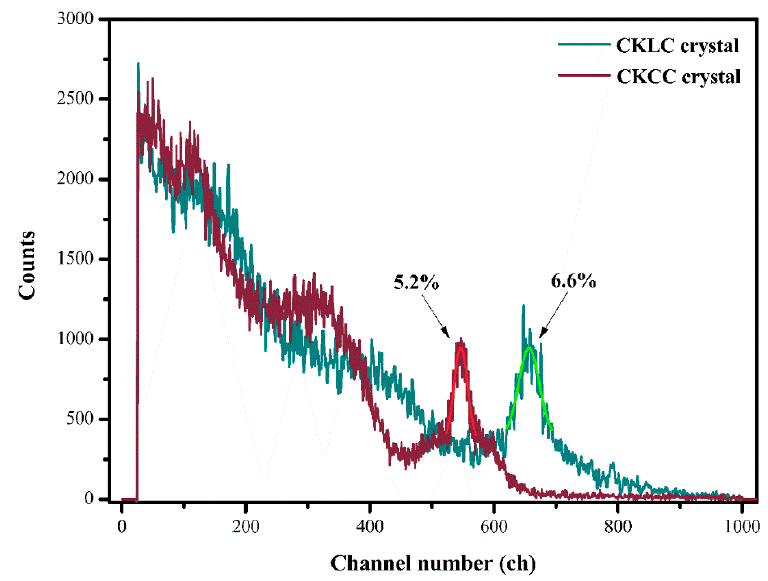
Figure 7. The scintillation pulse height spectrum of CKLC and CKCC irradiated with γ -rays from a 137 Cs source.